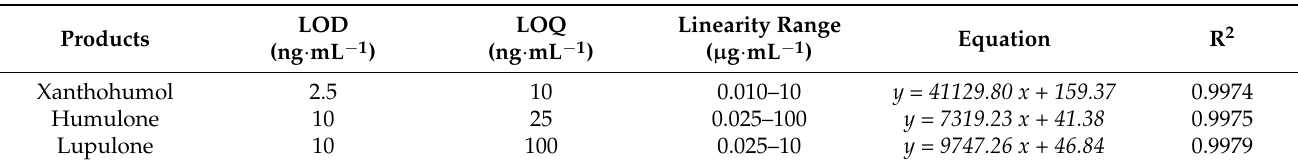
Table 1. Linearity and sensitivity of the quantification method from xanthohumol, humulone, and lupulone using